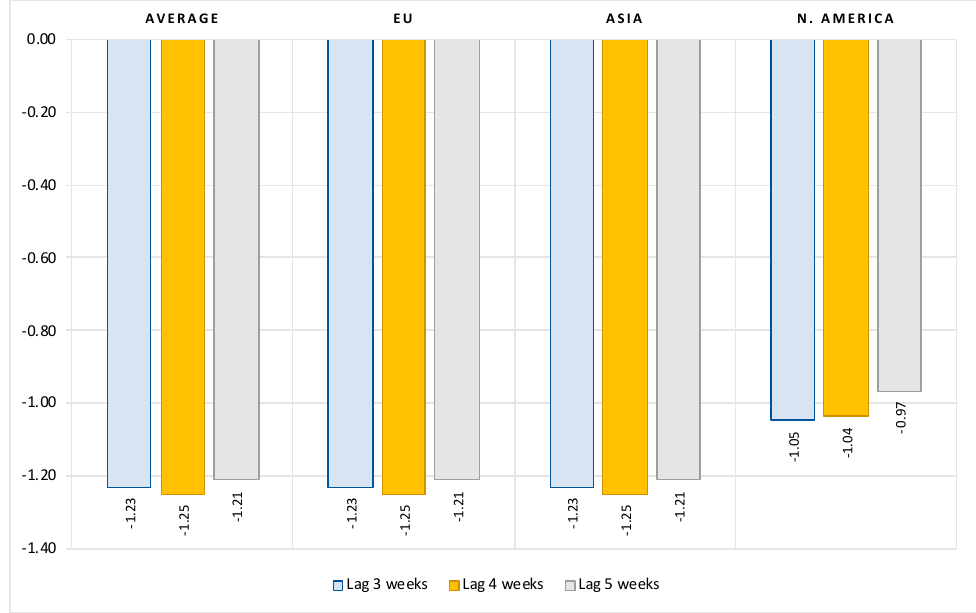
14 of 28 Figure 4. Impact of vaccination rate on number of new hospitalized patients, limited data sample *. Notes: Figure contains the estimated elasticities of the per-million number of new hospitalized pa- tients to vaccination rate obtained by estimating the model (2). (*) Data available only for most Eu- ropean countries, United States, Canada and Israel. See Table A4 in the Appendix for the full results. Figure 5 presents estimated elasticities for the impact of vaccination rate on number